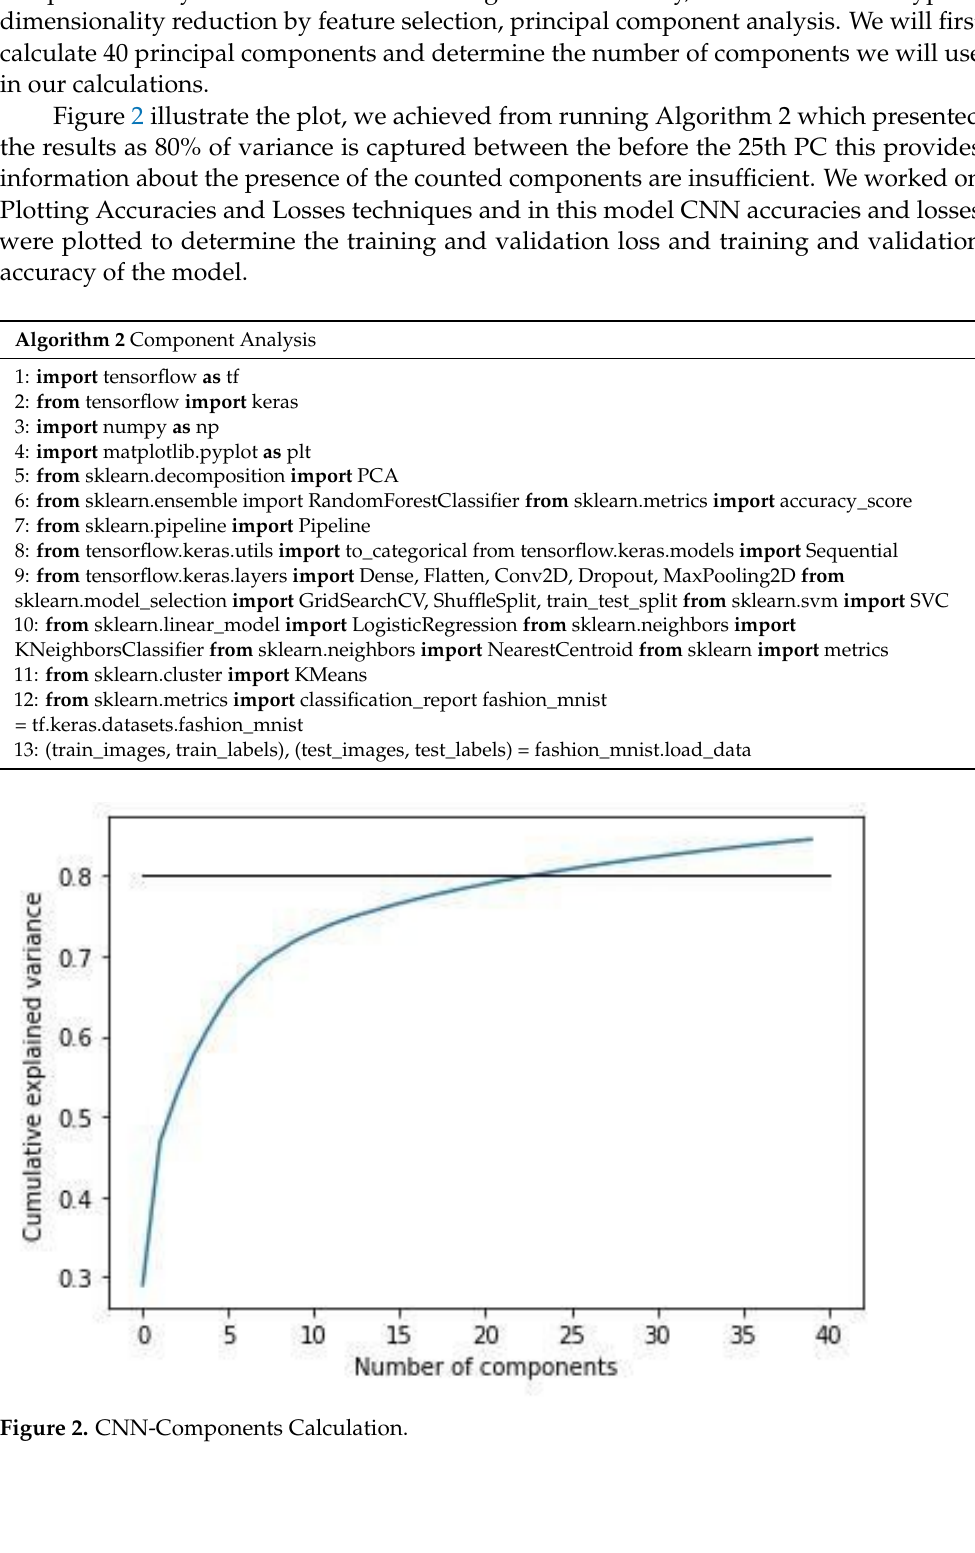
Algorithm 2 Component Analysis